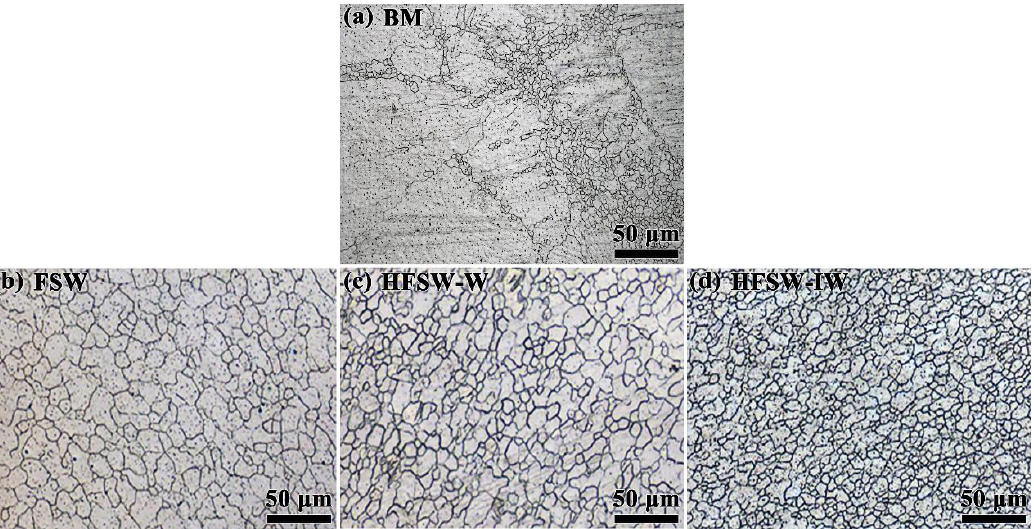
Figure 8. The microstructure of: ( a ) base material (BM); ( b ) the weld nugget zone (WNZ) under the FSW condition; ( c ) the weld nugget zone under the HFSW-W condition; ( d ) the weld nugget zone under the HFSW-IW condition; FSW means the conventional friction stir welding; HFSW-W indicates the heat pipe assisted friction stir welding with ambient temperature water as the cooling liquid;